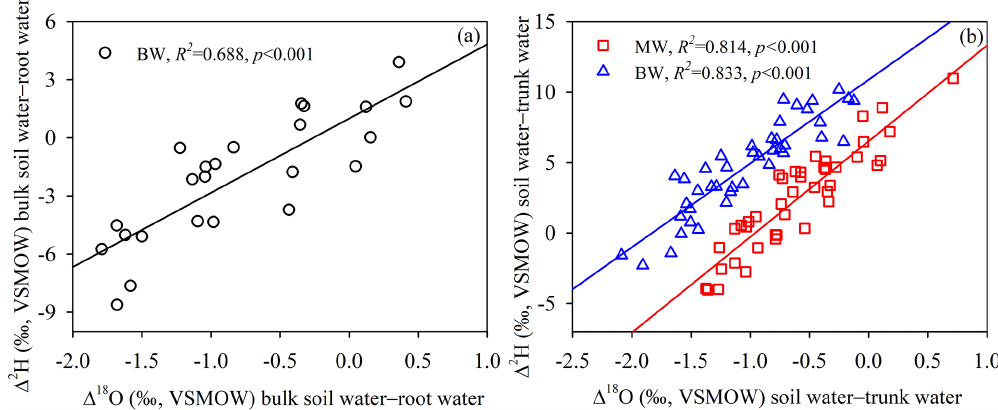
Figure 6. (a) Relationship of the hydrogen isotope offset ( (cid:49) 2 H, (cid:49) 2 H = δ 2 H soil − δ 2 H root ) to the oxygen isotope offset ( (cid:49) 18 O, (cid:49) 18 O = δ 18 O − δ 18 O root ) for comparisons between bulk soil water and root water, according to analyses of samples of bulk soil water (BW) soil and root water collected from 0–160cm depths on 18 August 2019. (b) Relationship of the hydrogen isotope offset ( (cid:49) 2 H, (cid:49) 2 H = δ 2 H soil − δ 2 H trunk ) to the oxygen isotope offset ( (cid:49) 18 O, (cid:49) 18 O = δ 18 O soil − δ 18 O trunk ) for comparisons between soil water and trunk water, according to analyses of samples of bulk soil water, mobile water (MW) and trunk water collected from 4 August to 15 September 2019. The insets summarize the goodness of fit of the linear regressions (a–b) .